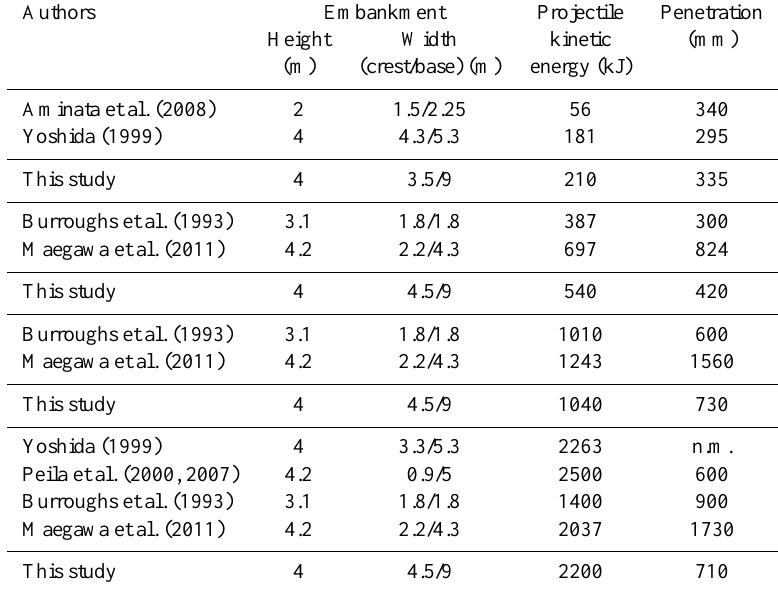
Table 3. Comparison with previous real-scale experiments with similar impact conditions (nm: not measurable).